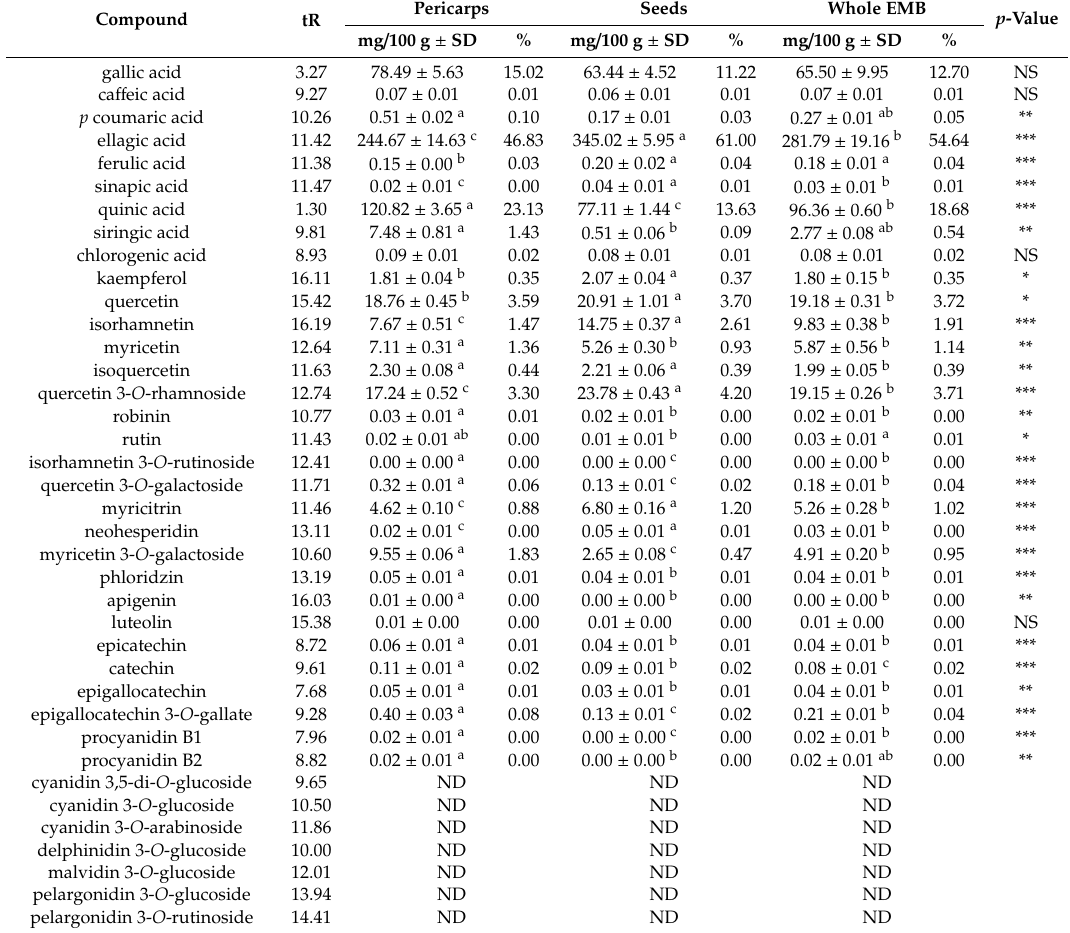
Table 4. Polyphenolic contents (mg / 100 g DW ± standard deviation) and percentages (%) of di ff erent part of exhausted berries of Myrtus communis . Compound tR